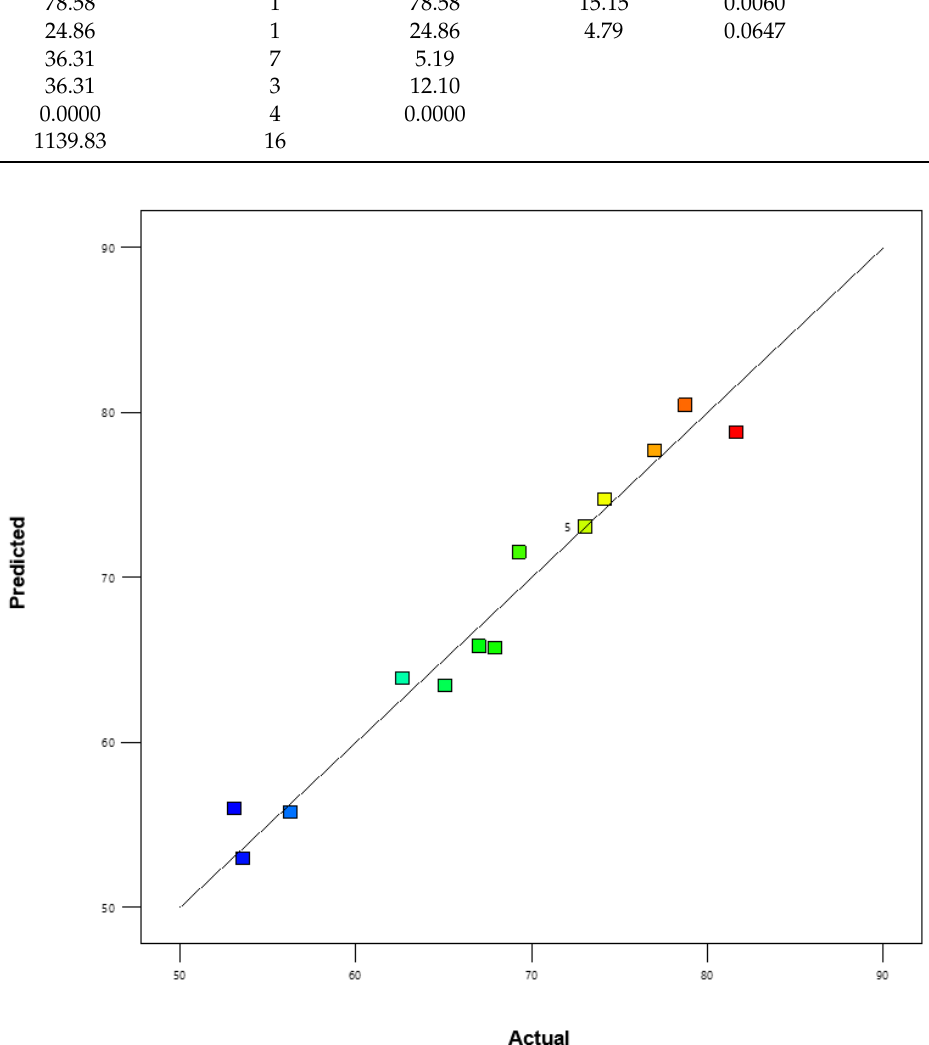
Figure 2. Actual verses predicted graph for the RDX degradation with Bacillus toyonensis. Similarly, in Figure 3A,B a reduction in RDX concentration with time was observed with Paenibacillus dendritiformis (isolate No. S10-TSA-3). With the increase in inoculum volume, a increase in degradation of RDX was observed. At the end of 15th day, maximum (84.7 ± 0.9%) RDX degradation was observed at 40 mg/L initial concentration with 6% inoculum volume, which was followed by 78.1 ± 1.1% at 20 mg/L concentration and 2% inoculum volume. The maximum degradation achieved was nearly 1.2 times higher than the minimum degradation (71.7 ± 1.1) observed at 20 mg/L concentration with 4% inoculum volume on 15th day. However, degradation in the control due to abiotic factors was 0.8% and 1.1% for Bacillus toyonensis (isolate No. WS4-TSB-3) and